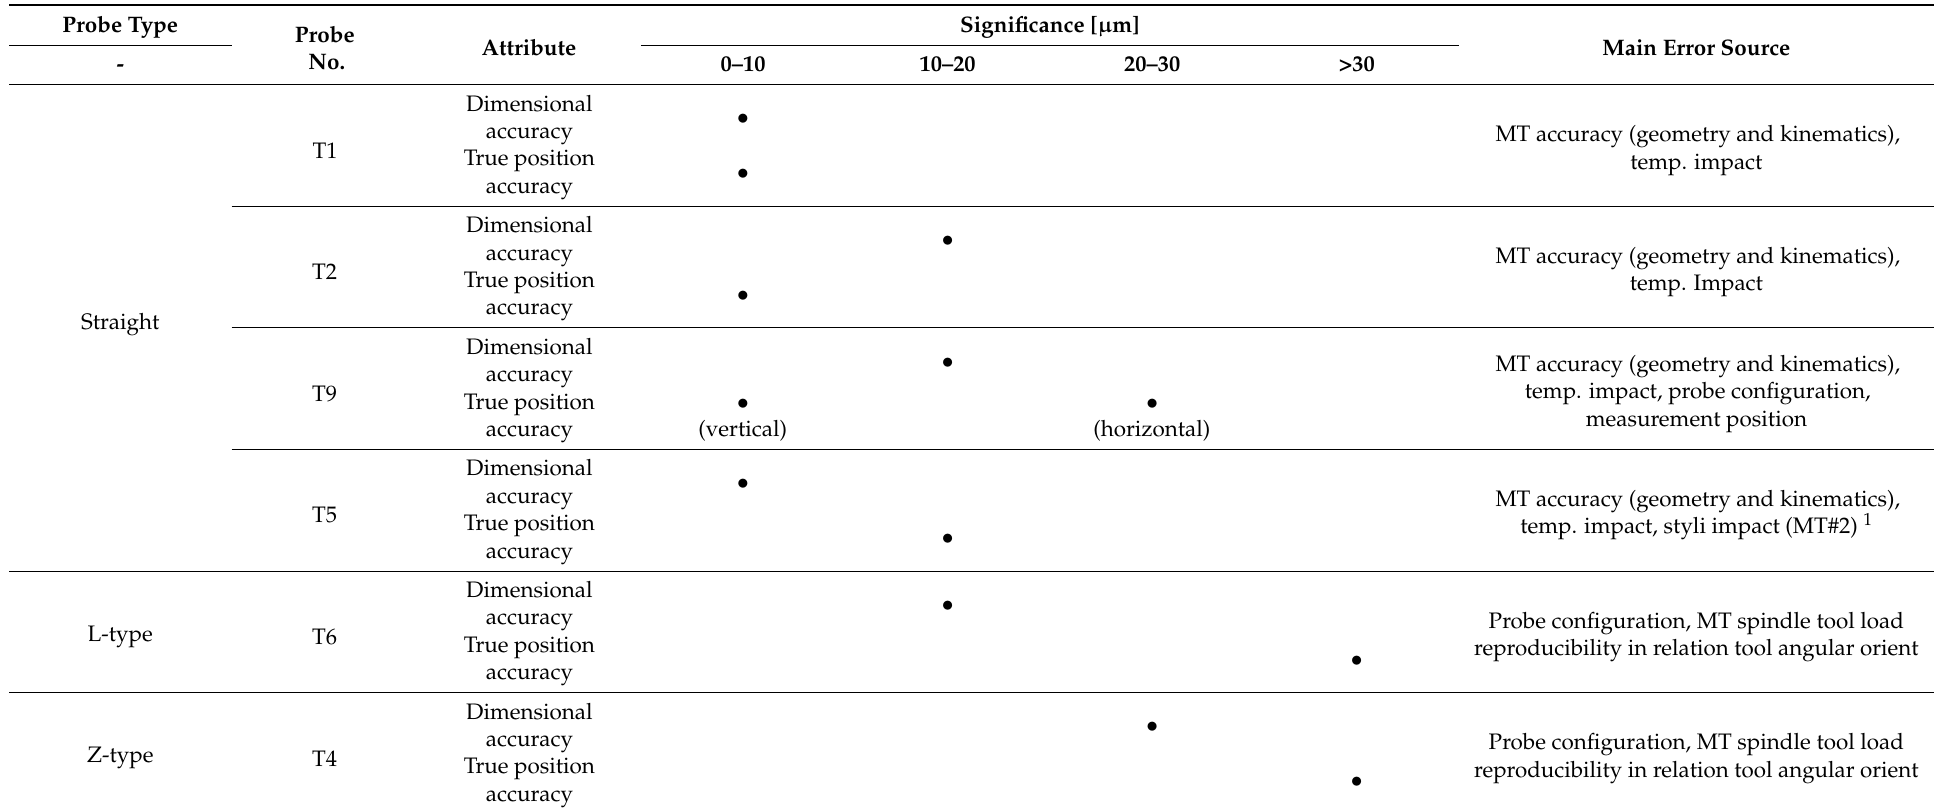
Table 14. Touch-trigger probe performance of analyzed probing